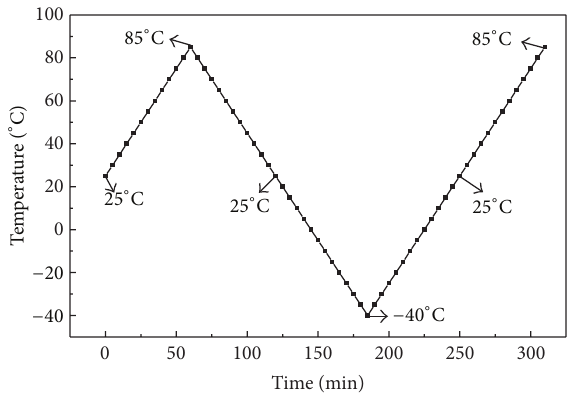
Figure 1: The high- and low-temperature cycle testing